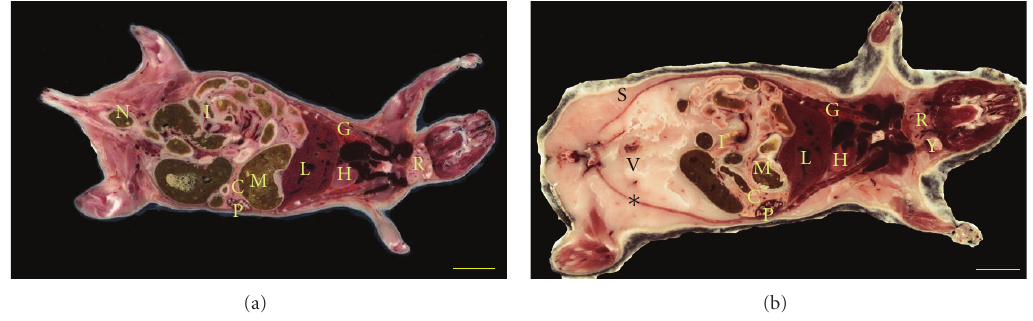
Figure 2: Comparison of a PEPCK-C mus mouse and a control mouse. A coronal 2D section (no. 390 of 586) of the transgenic PEPCK-C mus is shown in (a) while (b) shows similar coronal 2D section (no. 240 of 616) of the control mouse. Both images were composited by tiling 24 images each with an in-plane pixel size of 15.6 μ m. In both cases, the embedding compound OCT has been replaced with a background of black through automated image processing. Major organs like the heart (H), lungs (G), liver (L), salivary glands (R), stomach (M), spleen (P), pancreas (C), small intestine (I), colon (N), and lymph node (Y) are visible. Compared to the older PEPCK-C mus mouse, the control mouse has large amounts of visceral (V) and subcutaneous (S) adipose tissue. The peritoneum ( ∗ ) of the control mouse is thus distinctly visible (Bar = 10mm).